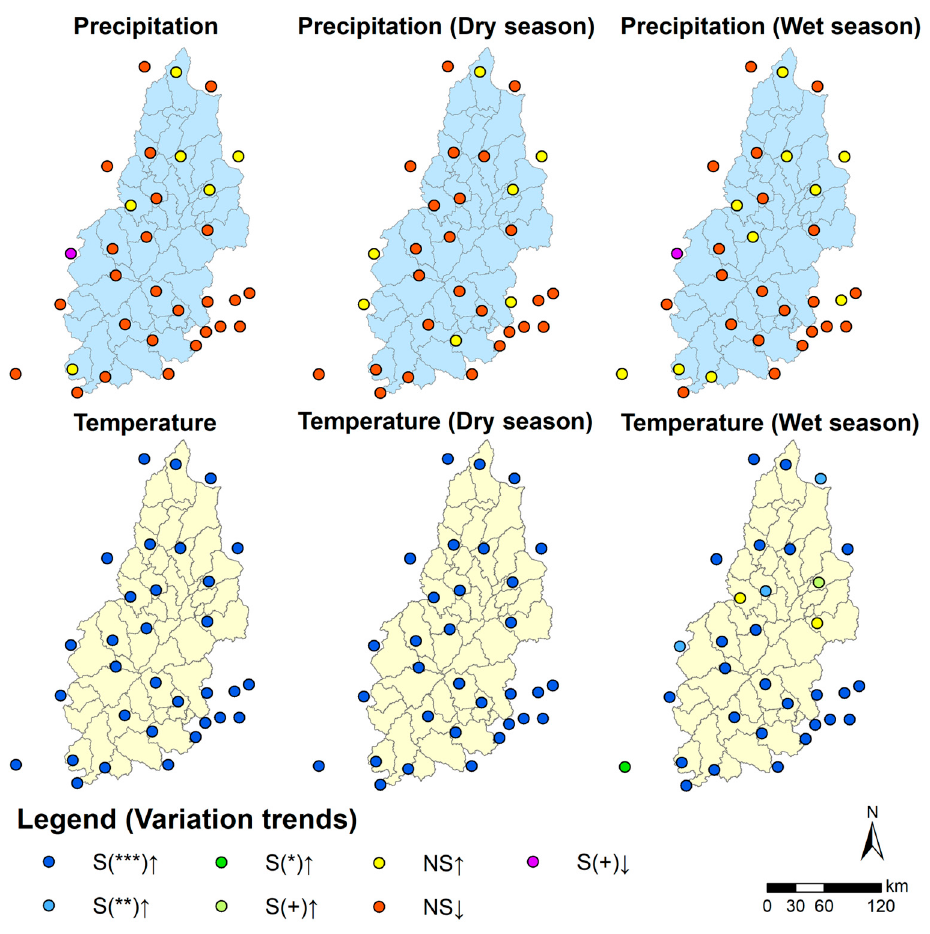
Figure 7. Spatial distribution pattern of variation trend of precipitation and temperature at stations from 1970 to 2020. Note a: S indicates significant M-K test; N.S. indicates not significant. ↑ Indicates an increase; ↓ indicates a decrease. Note b: *** indicates significant at the α = 0.001 level, ** indicates significant at the α = 0.01 level, * indicates significant at the α = 0.05 level, + indicates significant at the α = 0.1 level. Table 5. M-K, S-M-K, and S-E test results of climatic factors from 1970 to 2020.